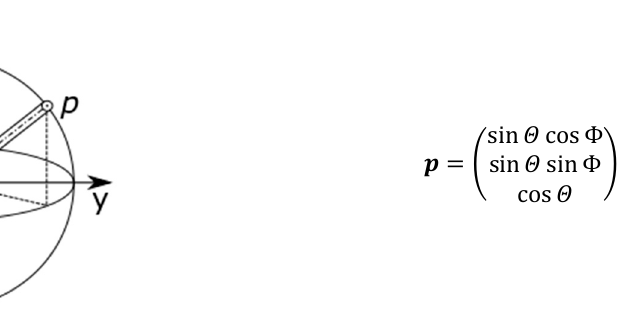
Figure 1. Orientation of single fiber in spherical coordinates.